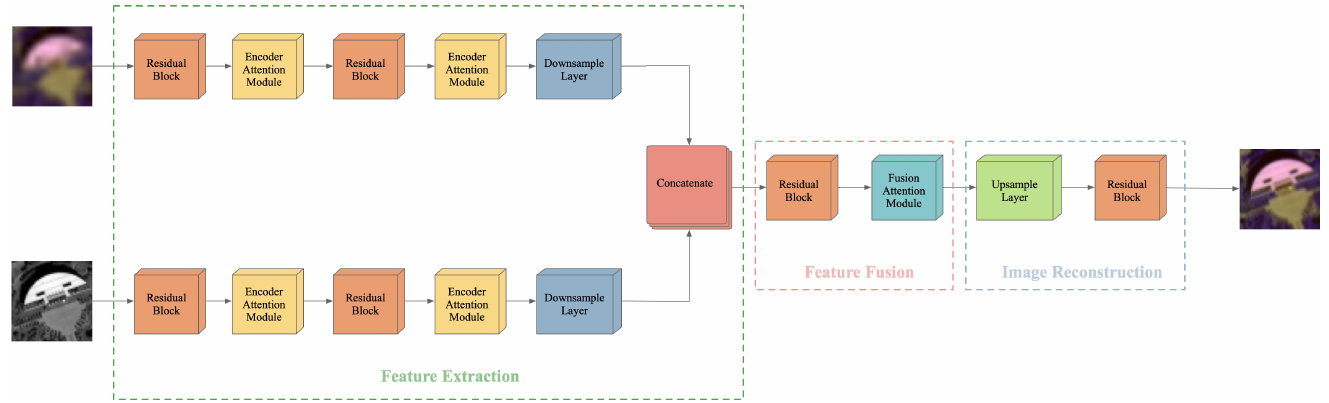
Figure 2. Network architecture of